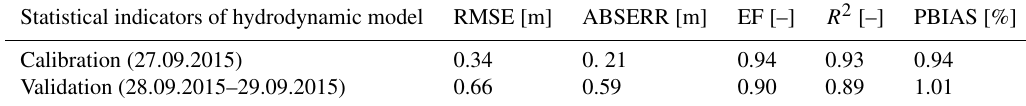
Figure 16. Salinity distributions in the Sebou estuary during spring tide, neap tide and supermoon total lunar eclipse day. Table 8. Statistical indicators of Hydrodynamic model performance in calibration and